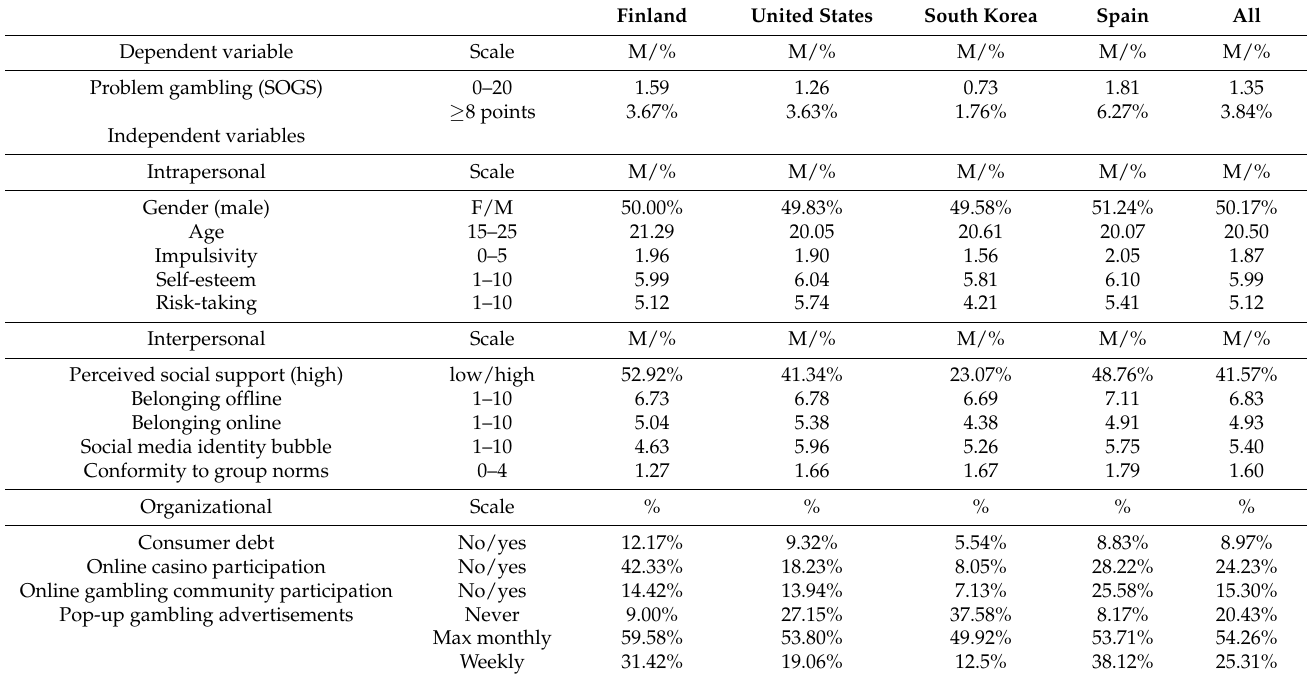
Table 1. Descriptive statistics of study